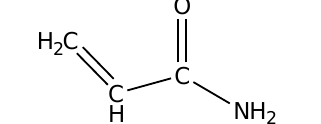
Figure 1. The chemical structure of